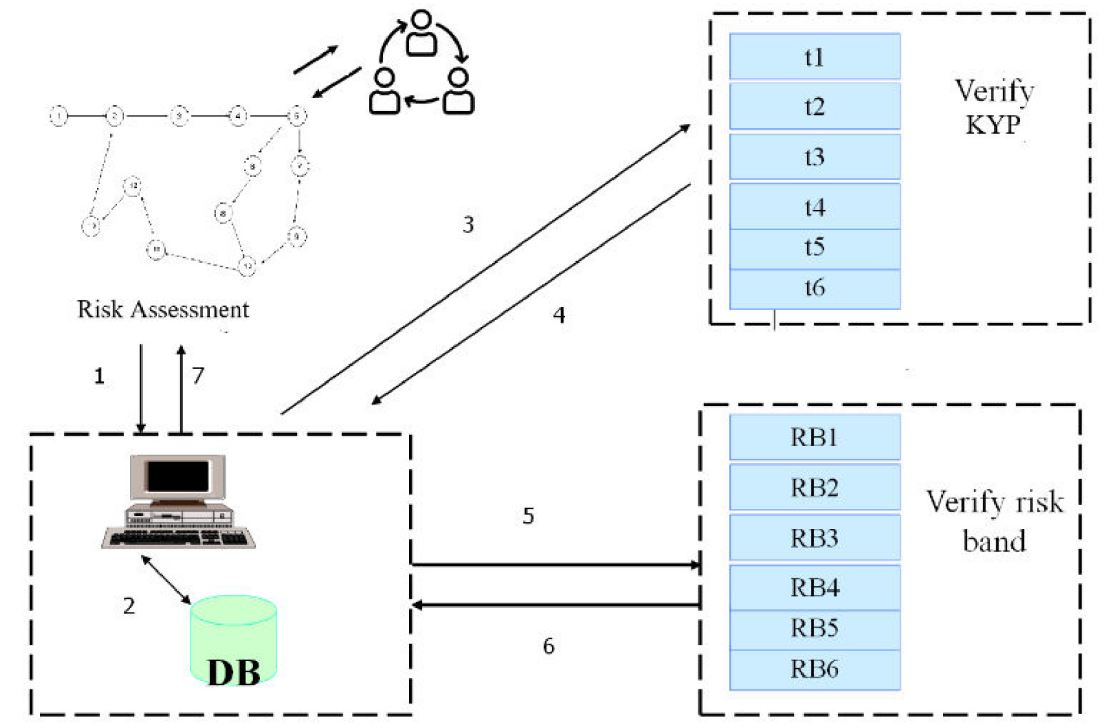
Figure 6. Agent Systems for autonomous platforms (Muthaiyah,